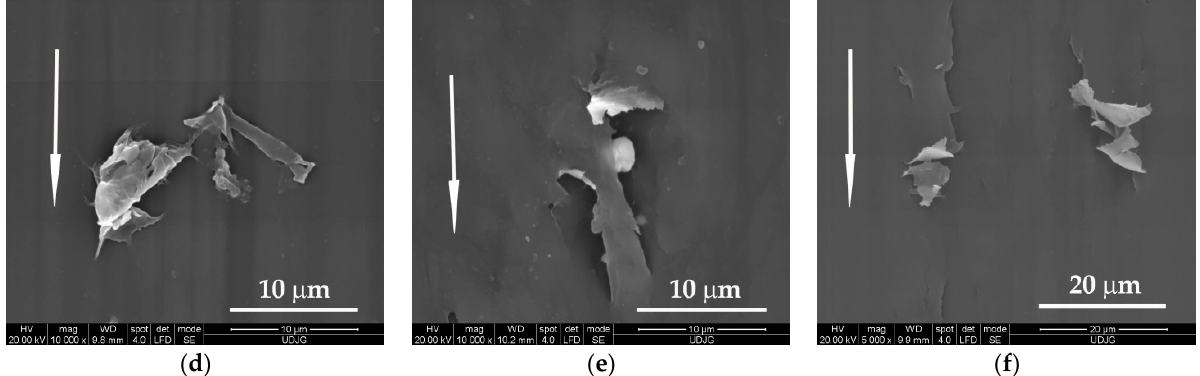
Figure 12. Wear debris after L = 5000 m: ( a ) PBT, F = 1 N, v = 0.25 m/s; ( b ) PF5, F = 5 N, v = 0,25 m/s; ( c ) PF10, F = 1 N, v = 0.25 m/s; ( d ) PF10, F = 1 N, v = 0.25 m/s; ( e ) PF15, F = 5 N, v = 0.25 m/s; ( f ) PF15, F = 5 N, v = 0.75 m/s.